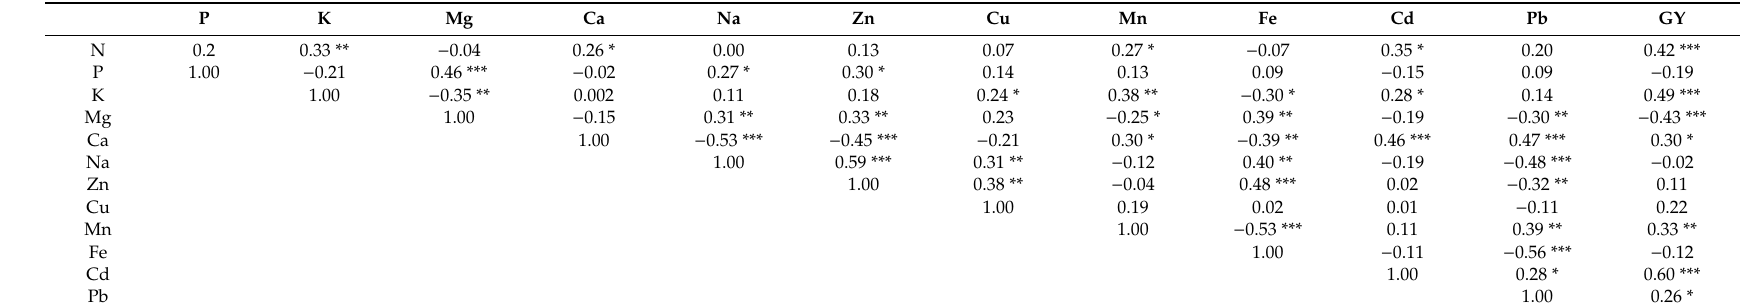
Table A2. Correlation matrix of relationships between elements in maize kernels and grain yield, n =